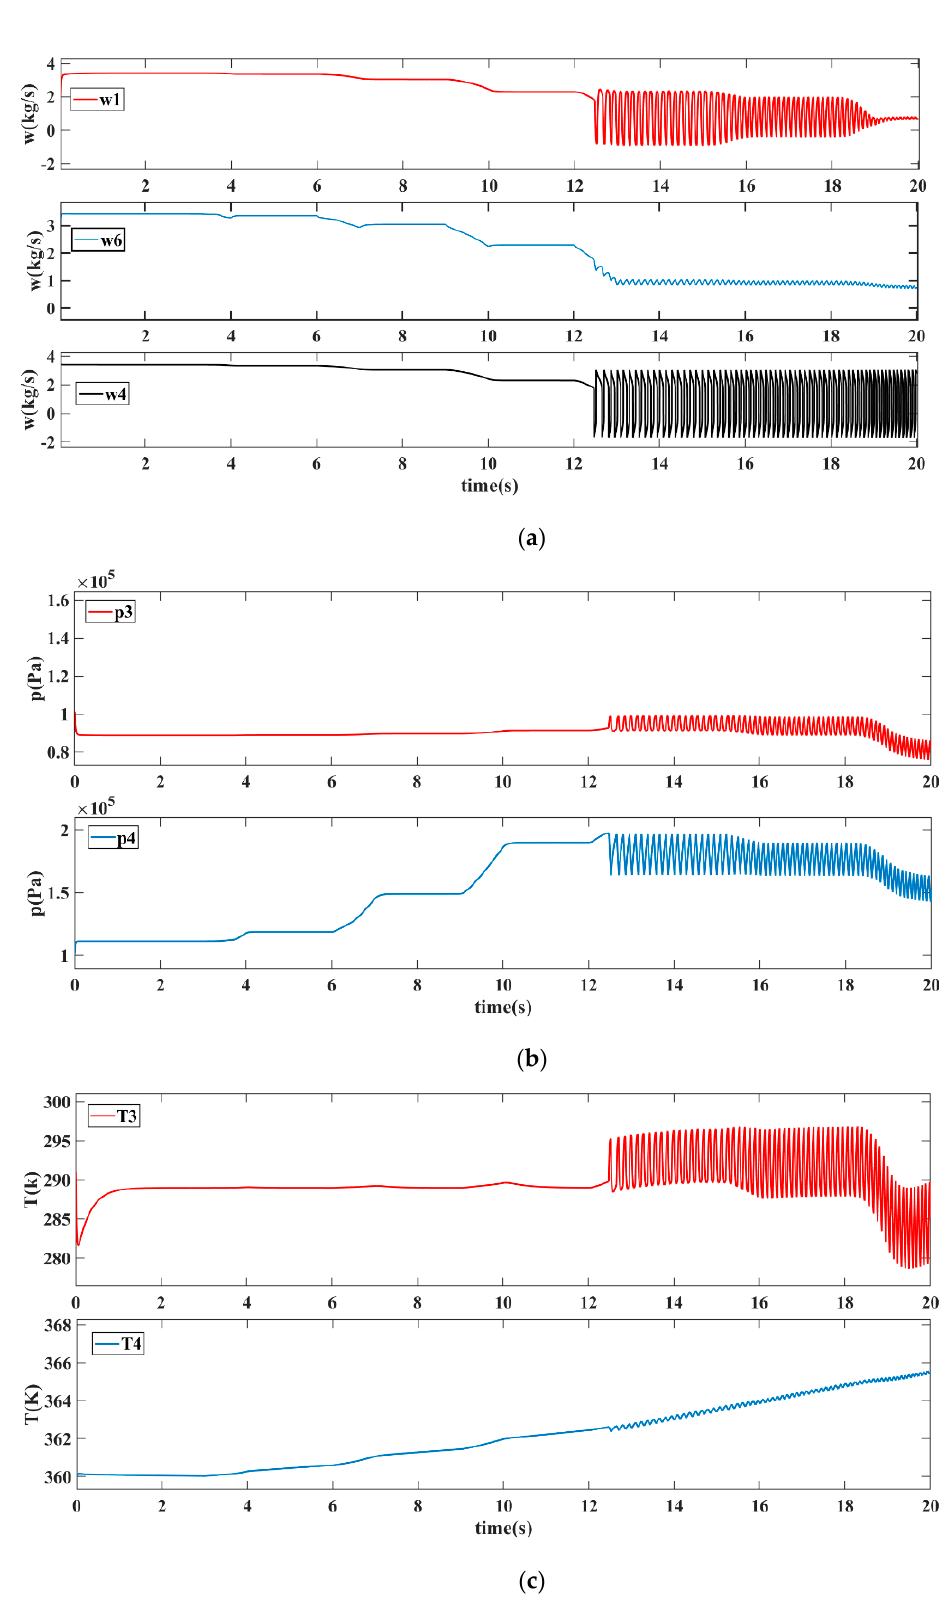
Figure 16. Mass flow ( a ), pressure ( b ), temperature ( c ) of the compression system with two throttle valves.